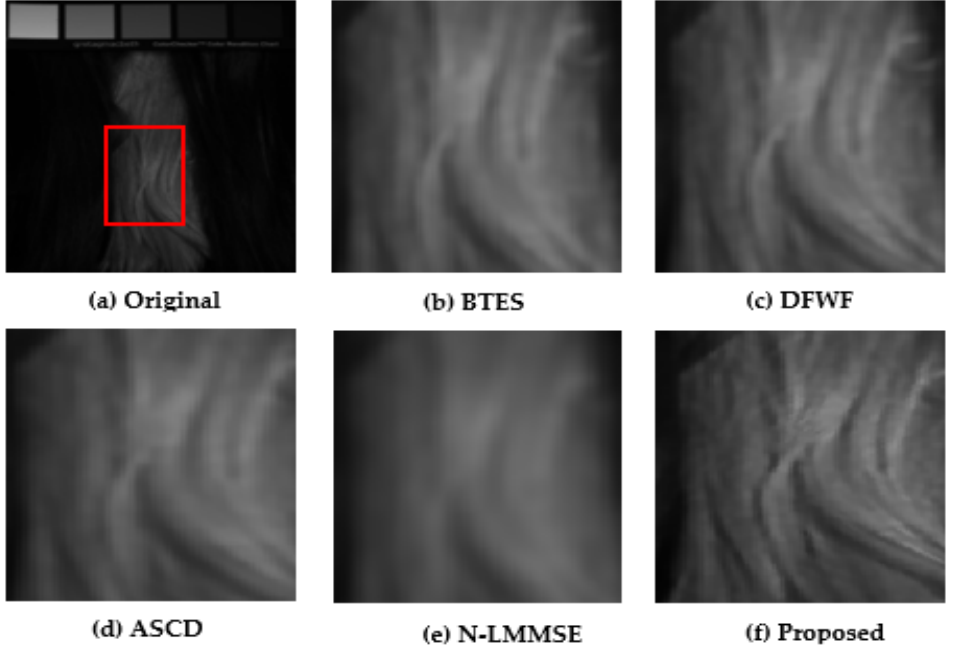
Figure 13. Visual comparison of red band in hairs image.